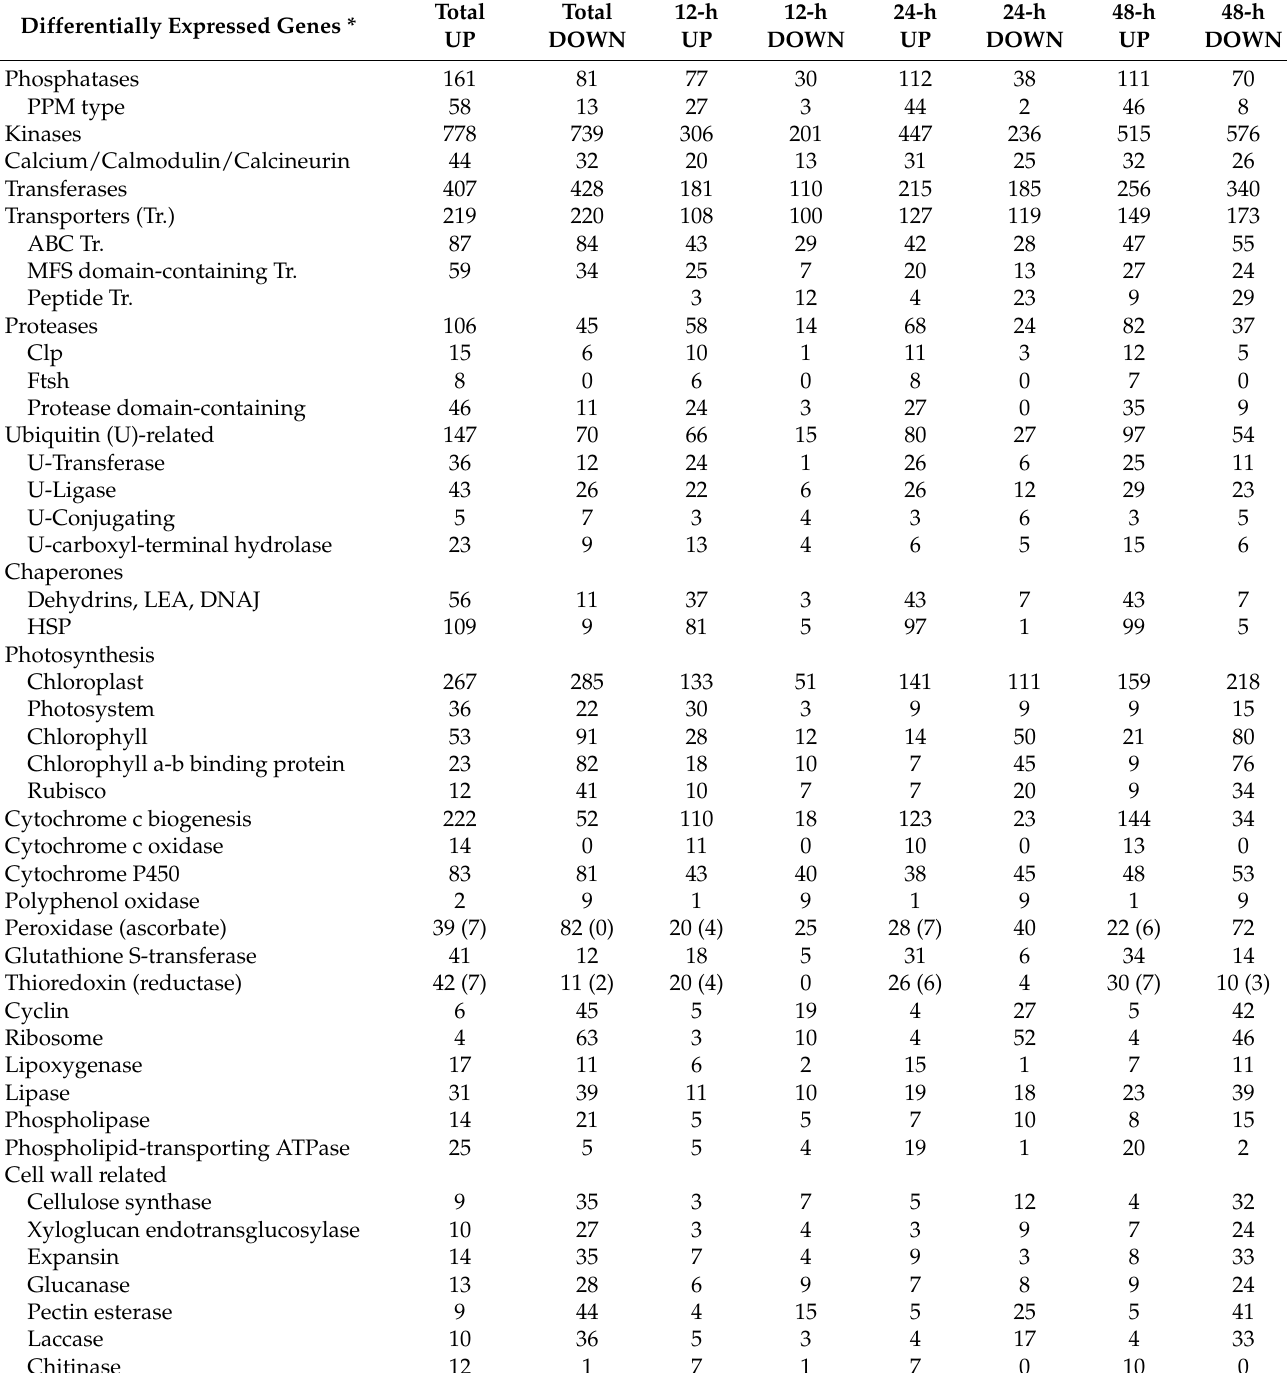
Table 2. Biological functional analysis of DEG